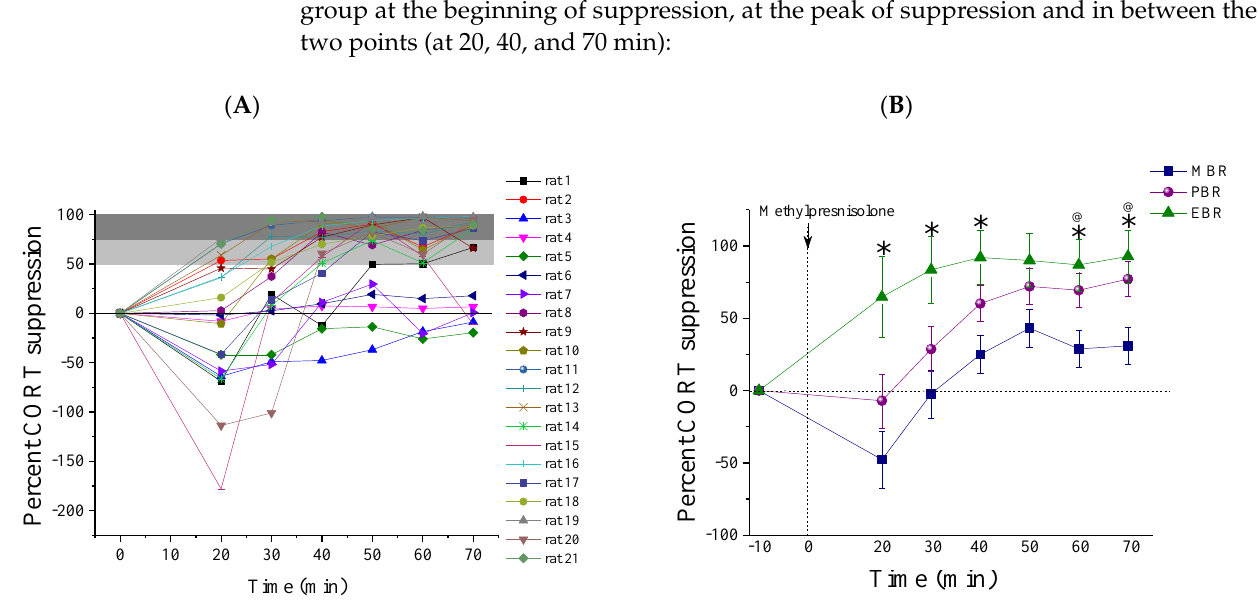
Figure 4. The percent of corticosterone suppression post-MPST. Corticosterone suppression in 10 min intervals over 60 min following MPST, depicted as a percentage of suppression from the baseline. ( A ) The percentage of suppression plotted for all individual rats. ( B ) The percentage of suppression between the different CBC groups (* MBR ≠ EBR, p < 0.04; @ MBR ≠ PBR p < 0.05; mean ± SEM).